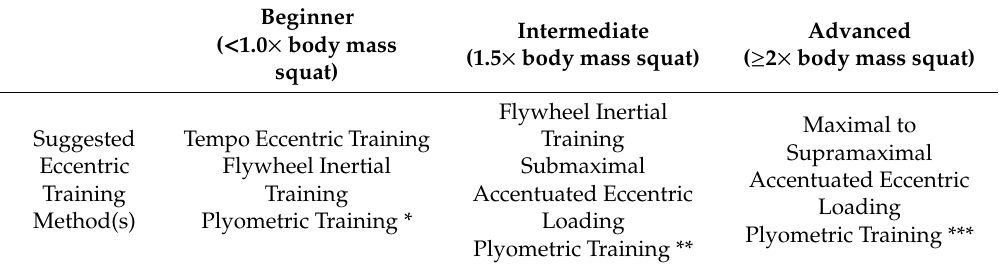
Table 2. Suggested eccentric training methods for beginner, intermediate, and advanced